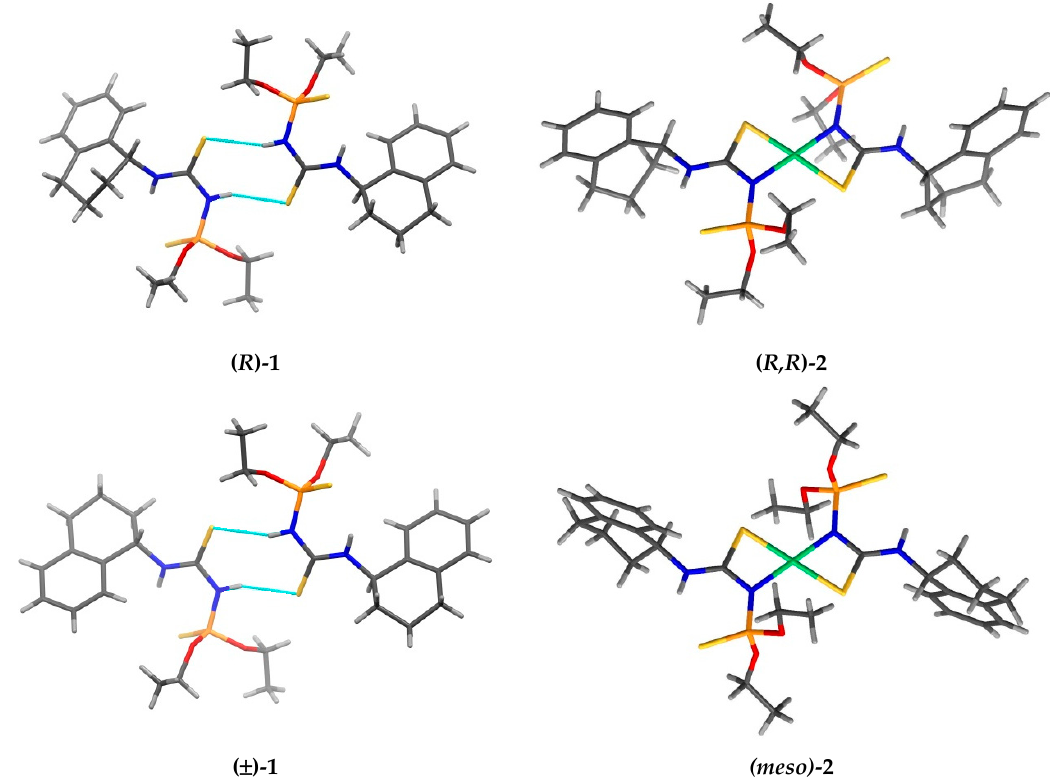
Figure 1. Hydrogen bonded dimers of 1 and square-planar Ni(II) complexes 2 in enantiopure and racemic crystals.